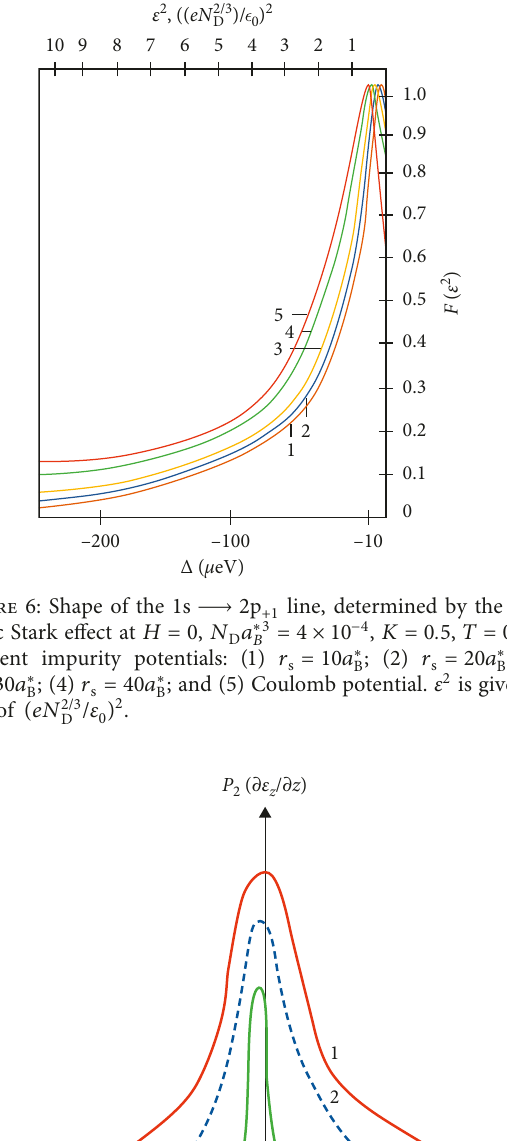
Figure 7: Distribution of P z ε z z on neutral donor at N D a z / 2 ( ) 4 and K 4 10 0 . 5 for different impurity potentials (1) Coulomb × (cid:29) potential at T (noncorrelated case), (2) Coulomb potential at − (cid:29) T 0, and (3) screened potential at T 0 with r s (cid:29) (cid:29) gradient z ε z / z z is given in unit of eN D / ϵ 0 ∞